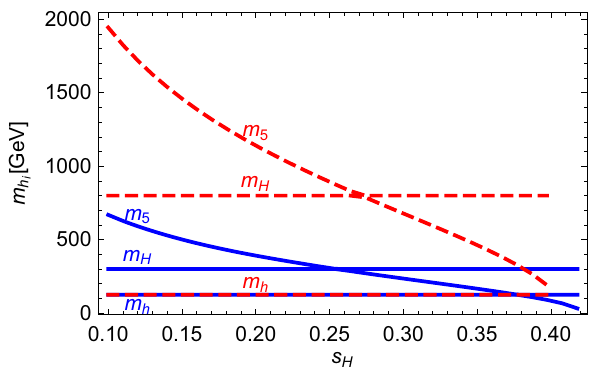
Fig. 2 The (tree-level) masses of the three CP-even states as function of s H for two different values of m H : 300 GeV (blue) and 800 GeV (dashed red). The other input parameters are: λ 2 = 0 . 1, λ 3 = 0 . 5, λ = − 0 . 02, λ = 0 . 1, α = 20 4 5